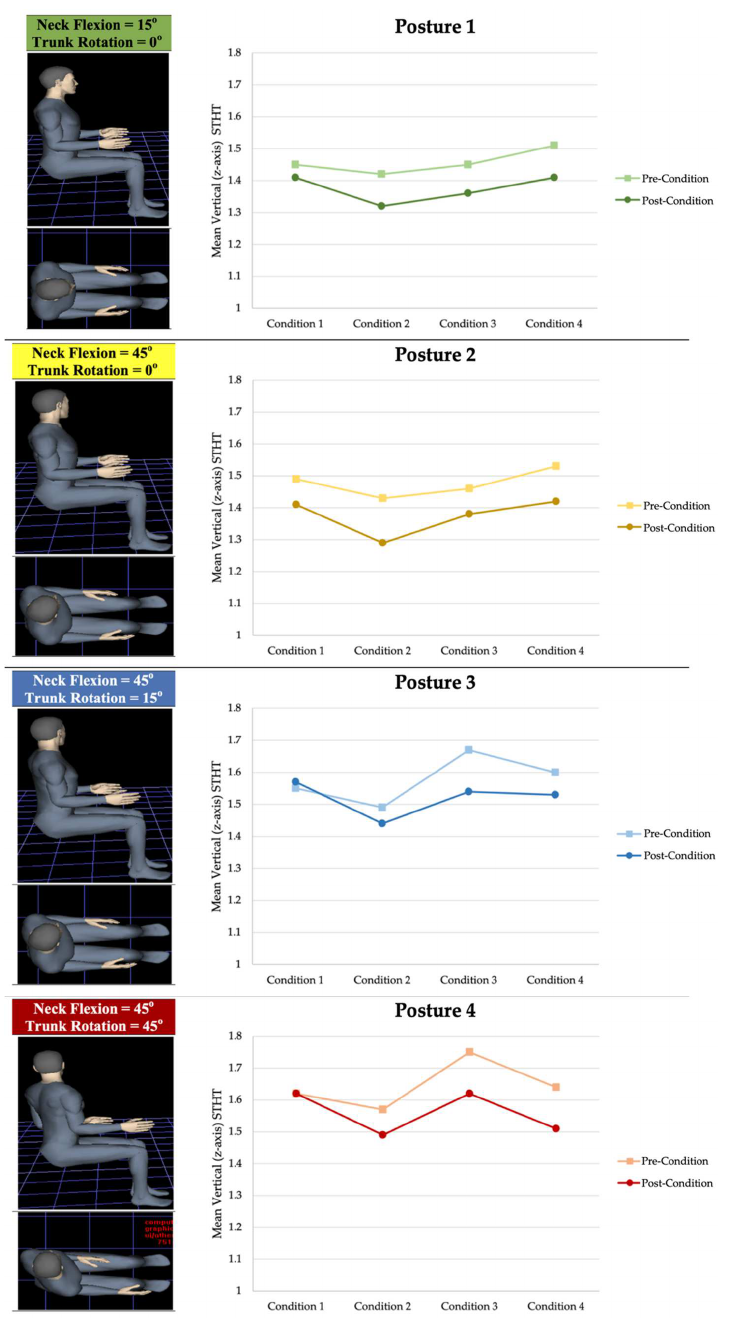
Figure 5. Mean vertical (z-axis) STHT in four rotated neck and trunk postures for 11 participants pre- and post-condition (i.e., before and after varying combinations of rotated postures and vibration exposure).